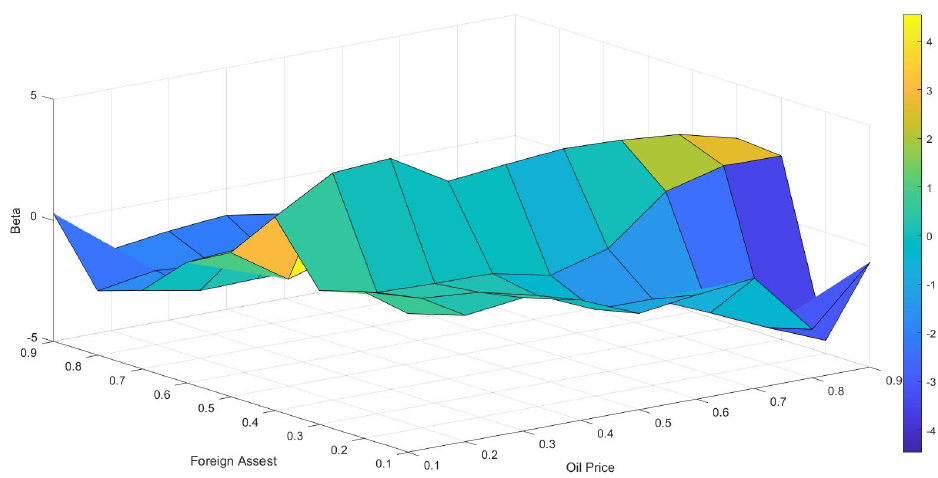
Figure 5. Response of foreign asset to oil price. Quarterly data.